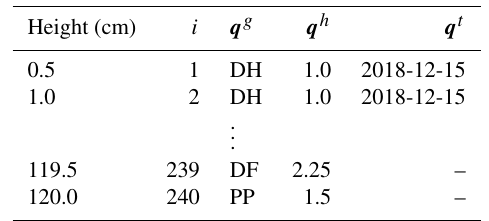
Table 3. An illustrative example of a resampled snow profile Q that contains information about the vertical position of the profile layers (at their top interfaces), the grain types q g , the hardnesses q h , and the (burial) dates q t